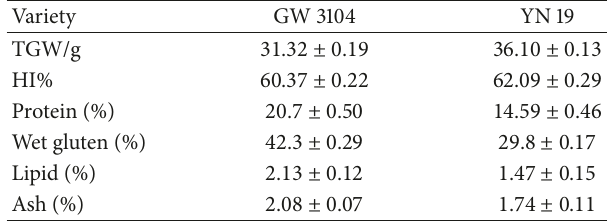
Table 1: Flour yield of different wheat variety by milling methods. Variety